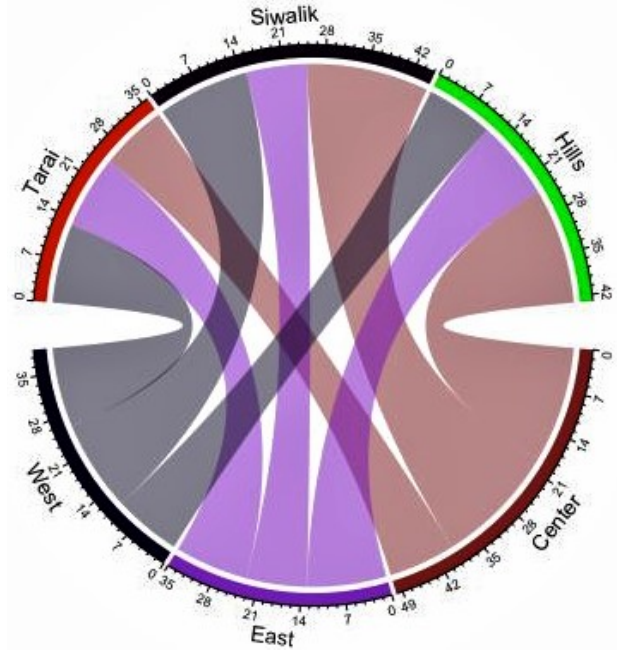
Figure 3. Chord diagram showing shared ant genera in Tarai and Siwalik and the hills of western, central, and eastern regions of Nepal.